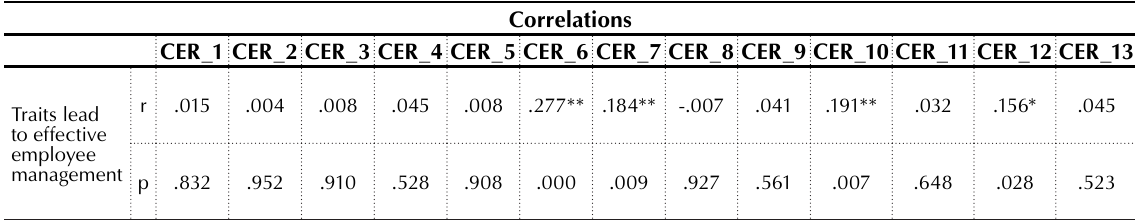
Table 3. Correlation analysis on